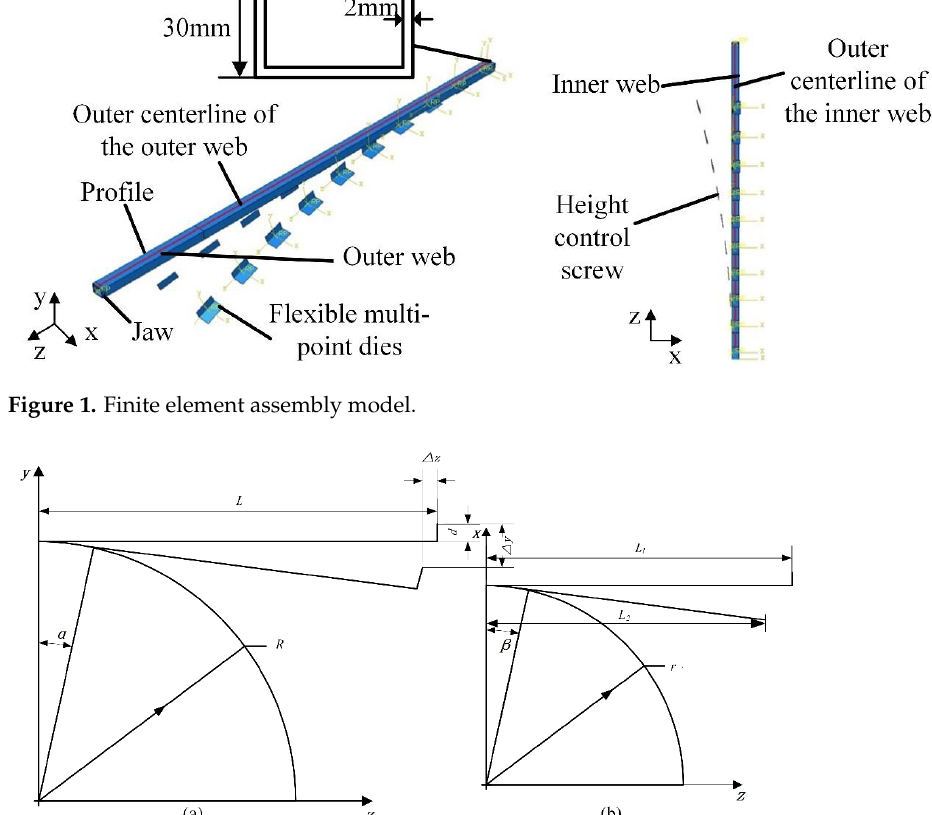
vertical bending: